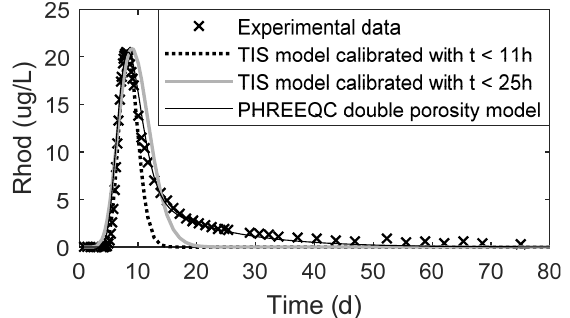
Figure 3. Comparison of the tank-in-series (TIS) model and the PHREEQC double porosity model used for the calibration of a typical tracer test in a 1D steel slag filter. Experimental data: tracer test in column 1 at t = 271 d. Rhod refers to the rhodamine dye tracer.